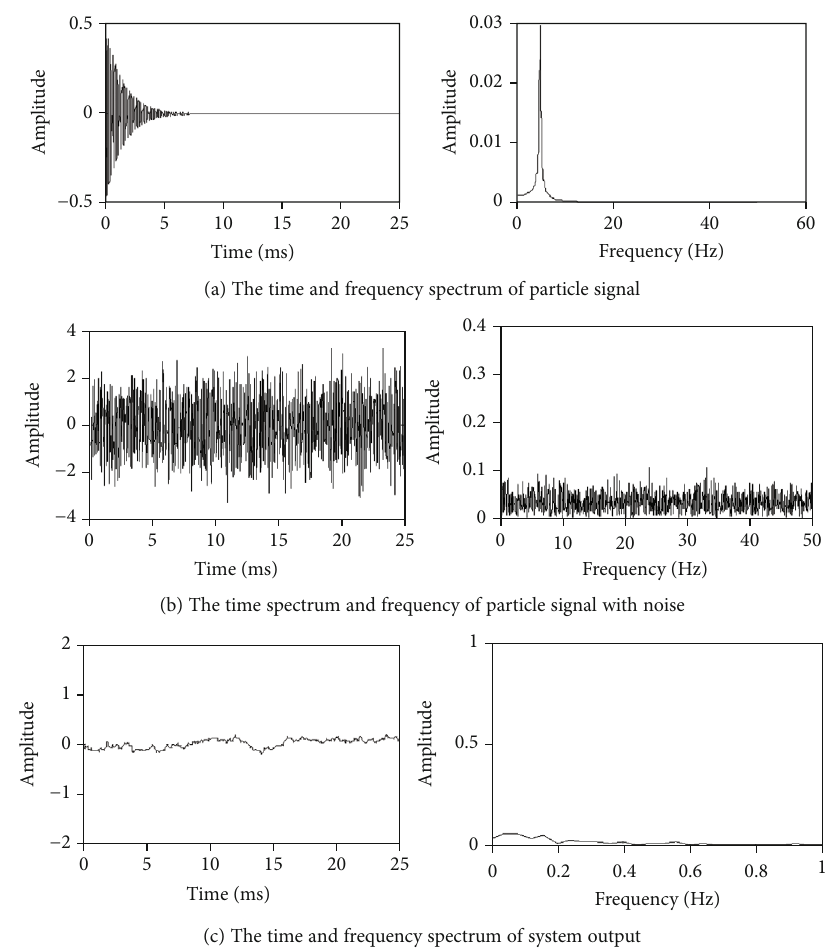
Figure 6: The time and frequency spectrum of the system input and output when a = 50 and b = 0 : 8 .